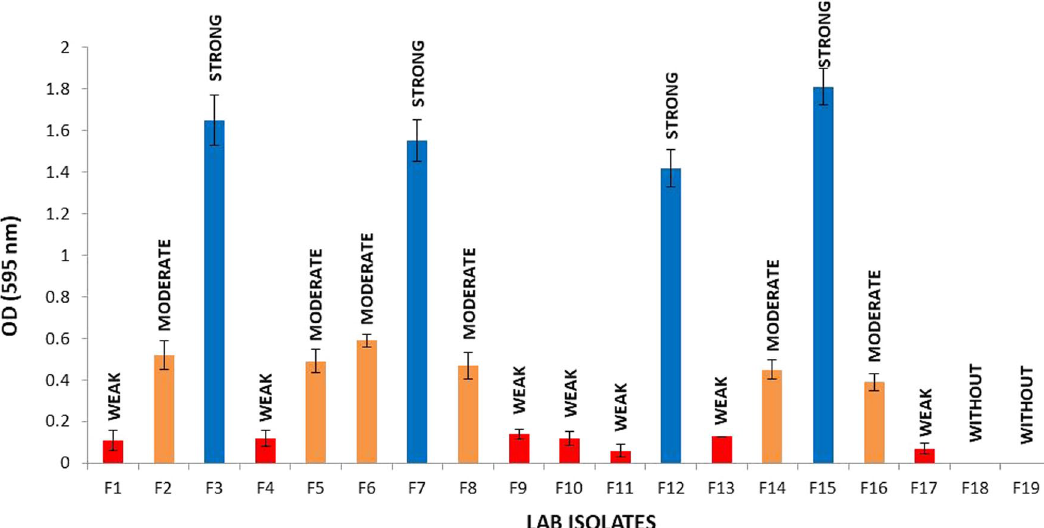
Figure 3. Biofilm formation ability of selected strains. Bars represent standard errors of the mean (n = 3). Based on the OD, bacteria were classified as non-biofilm producers (OD ≤ ODC), weak (ODC < OD ≤ 2 × ODC), moderate (2 × ODC < OD ≤ 4 × ODC) or strong biofilm producers (4 × ODC < OD; Borges et al., 2012). Where the cut-off (ODC) was defined as the mean OD value of the negative